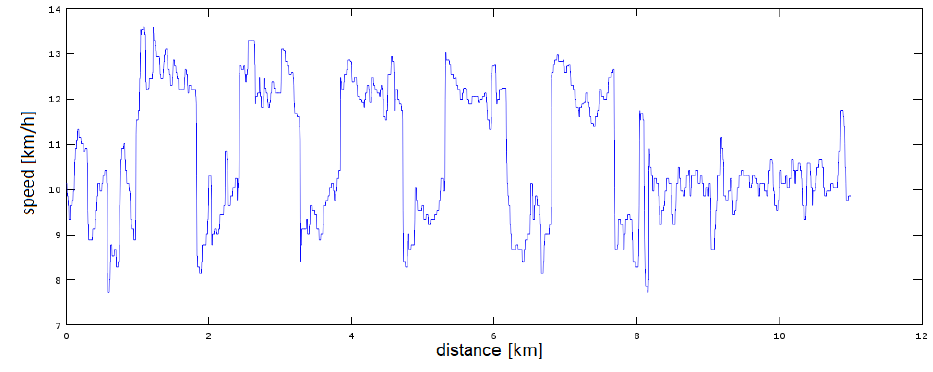
Figure 7. Running interval before filtration